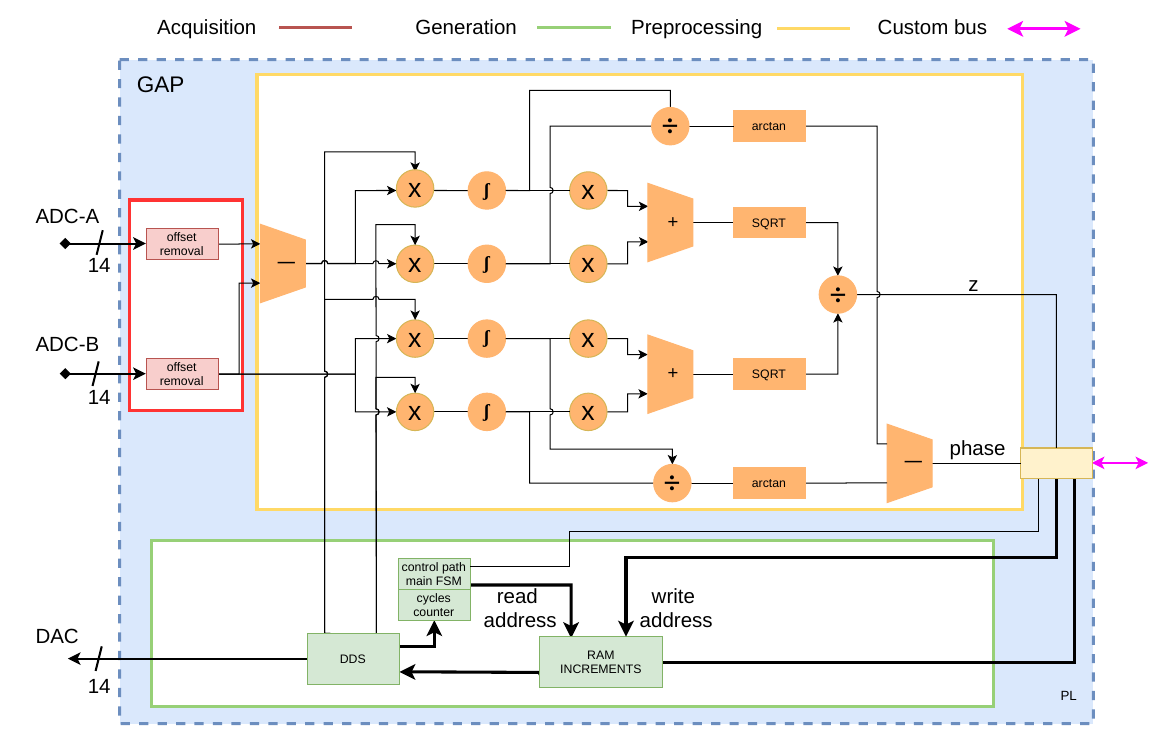
Figure 2. Generation, acquisition and preprocessing implemented GAP